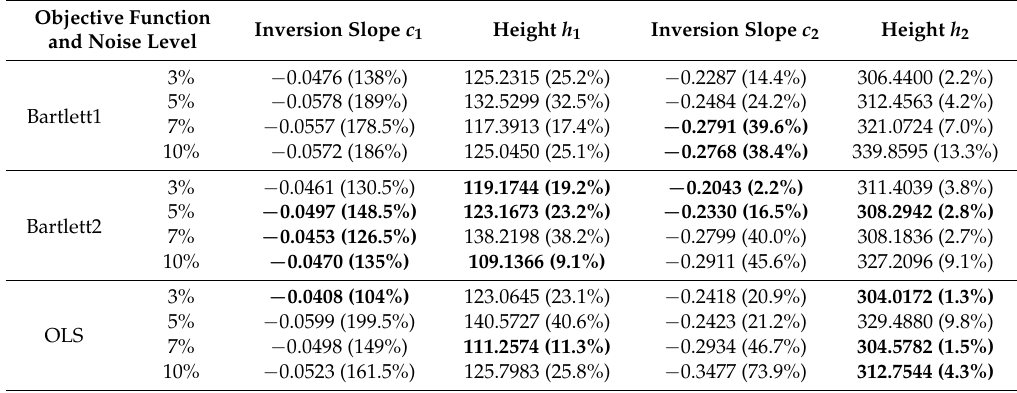
Table 4. The value of inversion parameters by NSSAGA with different objective functions and Gaussian noise (bold font indicates best retrieved parameters).